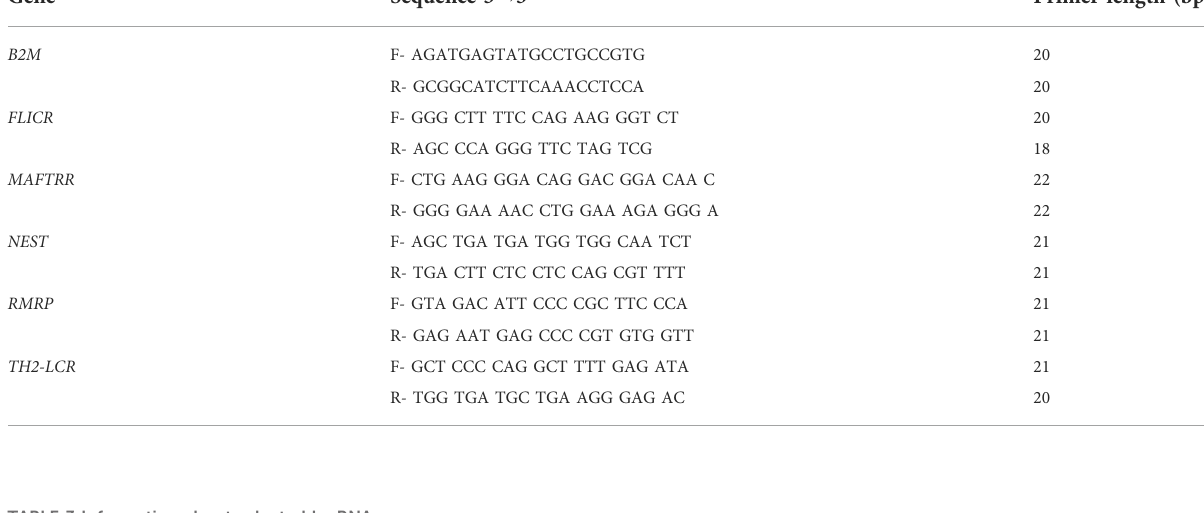
TABLE 3 Information about selected